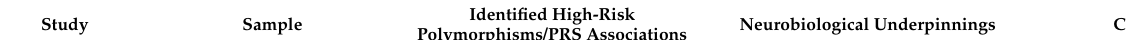
Table 1. Overview of GWAS focusing on comorbid mood, anxiety, and alcohol use